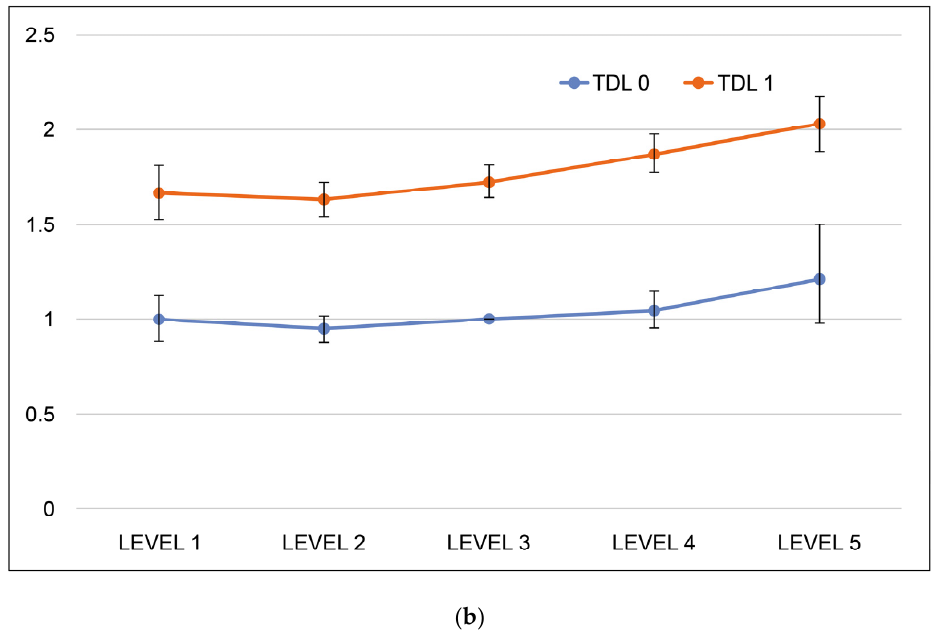
Figure 1. Graph representing hazard ratio for MI by groups listed in Supplementary Table S1. ( a ) p for trend TDL 0 = 0.025/TDL 1 = 0.007, ( b ) p for trend TDL 0 = 0.025/TDL 1 = 0.025. T, hypertension; D, diabetes; L, hyperlipidemia.